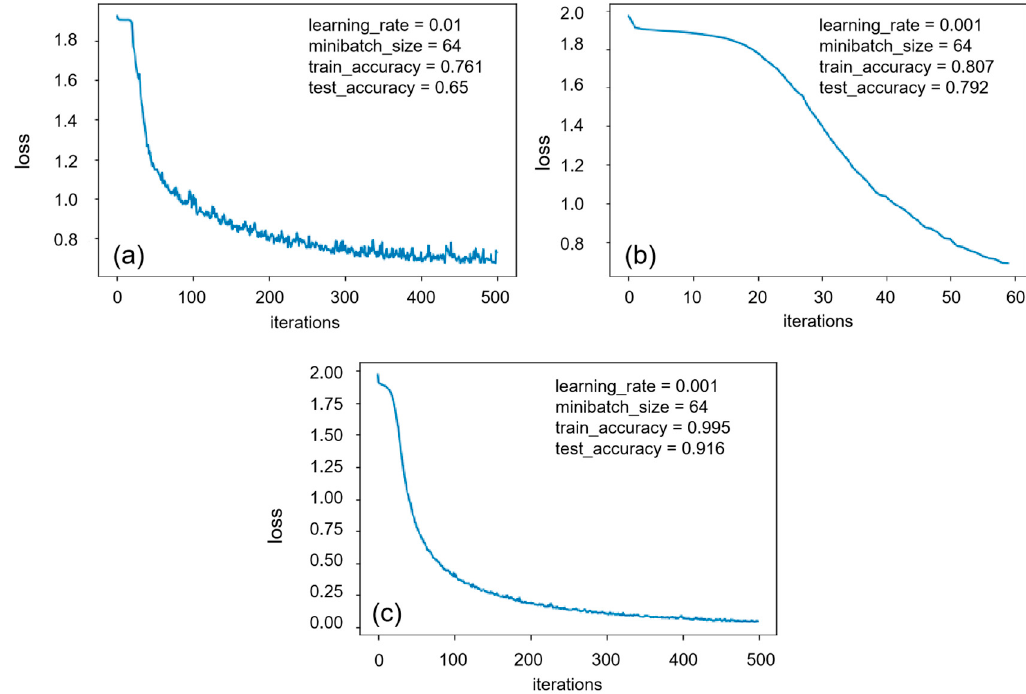
Figure 2. Schematic diagram of the result of the CNN classification model.